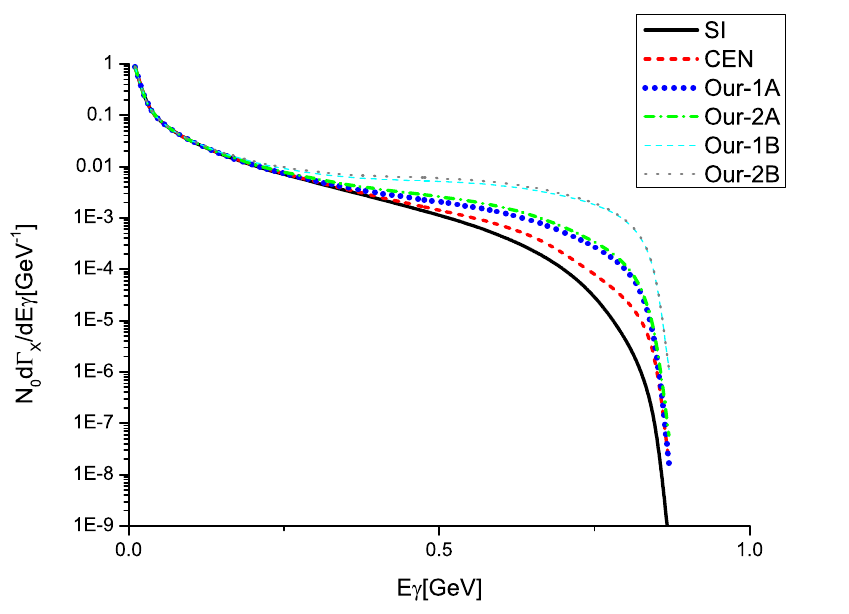
Figure 5 . Photon energy distribution in the τ − → π − π 0 γν τ process. Notice that the differential width of τ − → π − π 0 γν τ is normalized to the decay width of the non-radiative process τ − → π − π 0 ν τ , i.e. N 0 = 1 / Γ . The curve labeled as SI is the result by only taking the inner τ − → π − π 0 ν τ